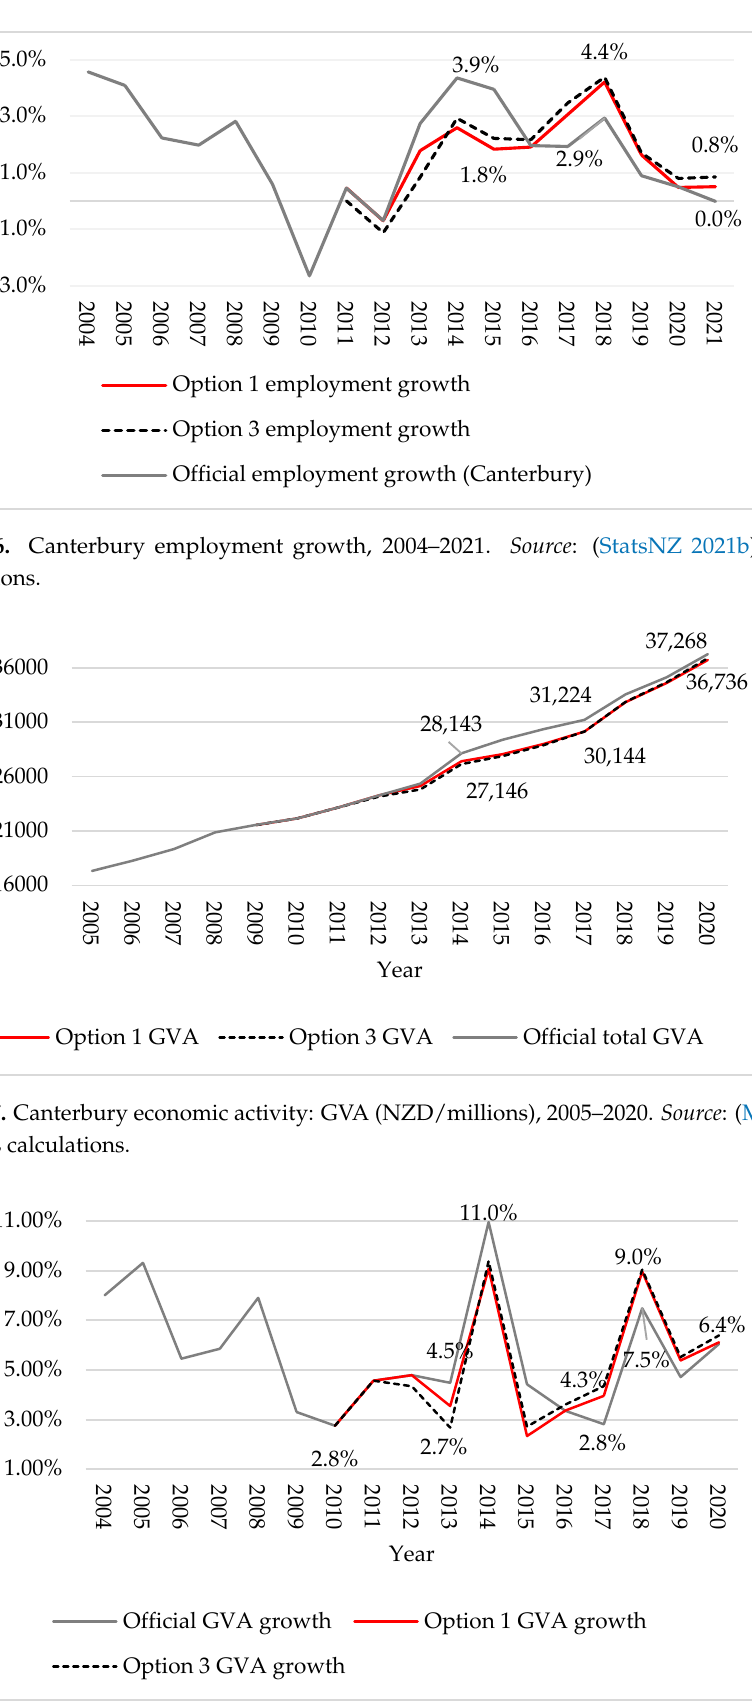
Figure 5. Canterbury employment numbers, 2005–2021. Source : (StatsNZ 2021b) and author’s calcu- lations.